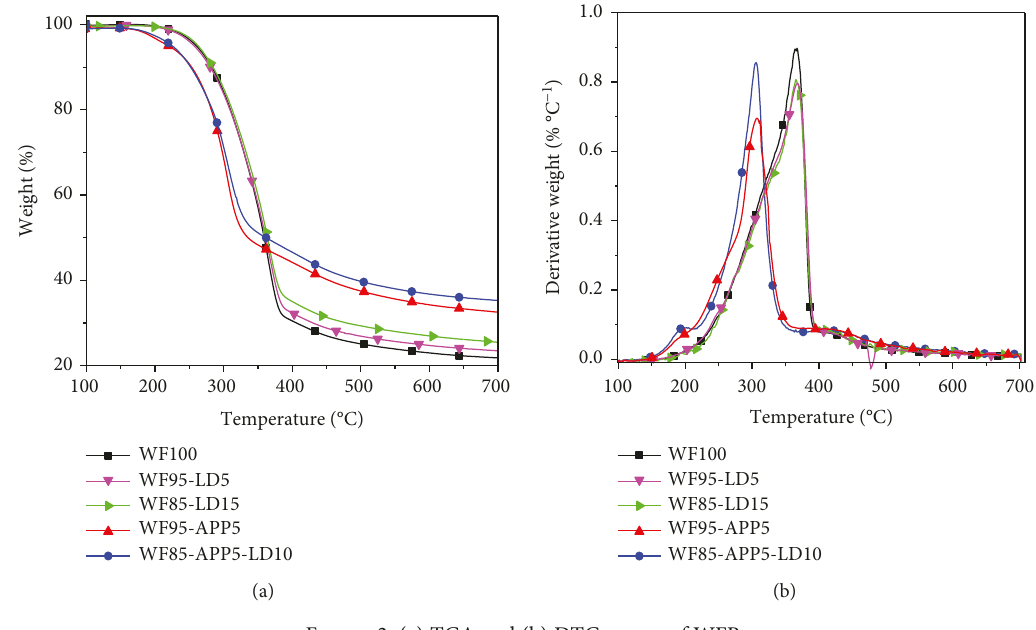
Figure 2: (a) TGA and (b) DTG curves of WFP.